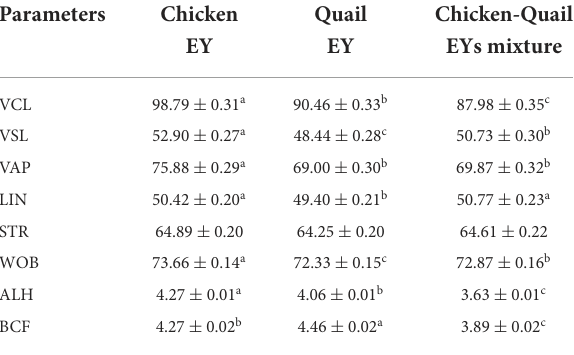
TABLE 2 Effects of adding and combining egg yolks (EY) of chicken and/or quail to the Tris glycerol extender on motion kinetics parameters of ram sperm before freezing.